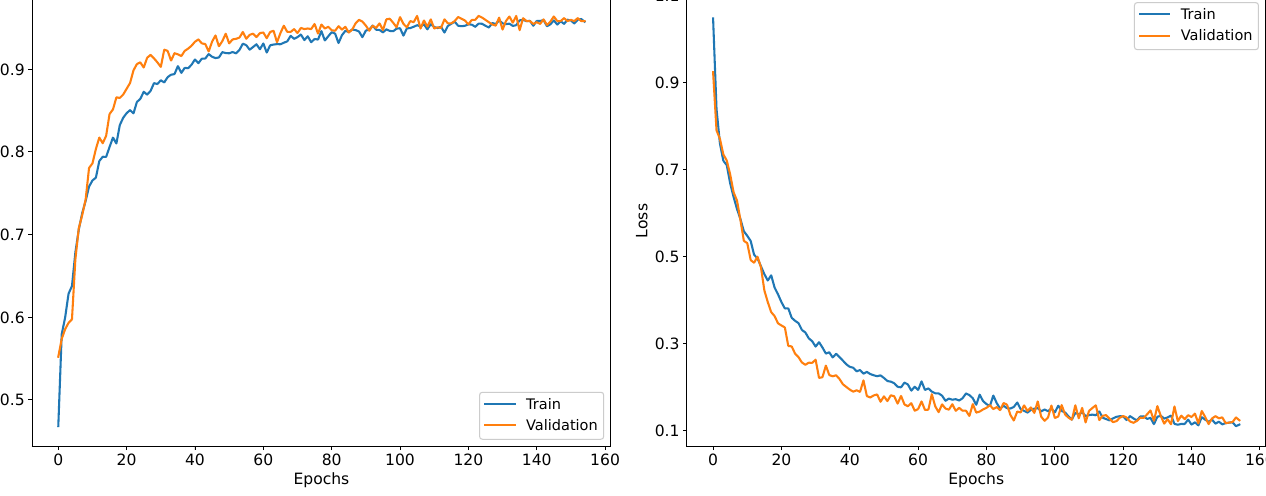
Figure 6. Accuracy and loss curves of our proposed 1D-CNN-based